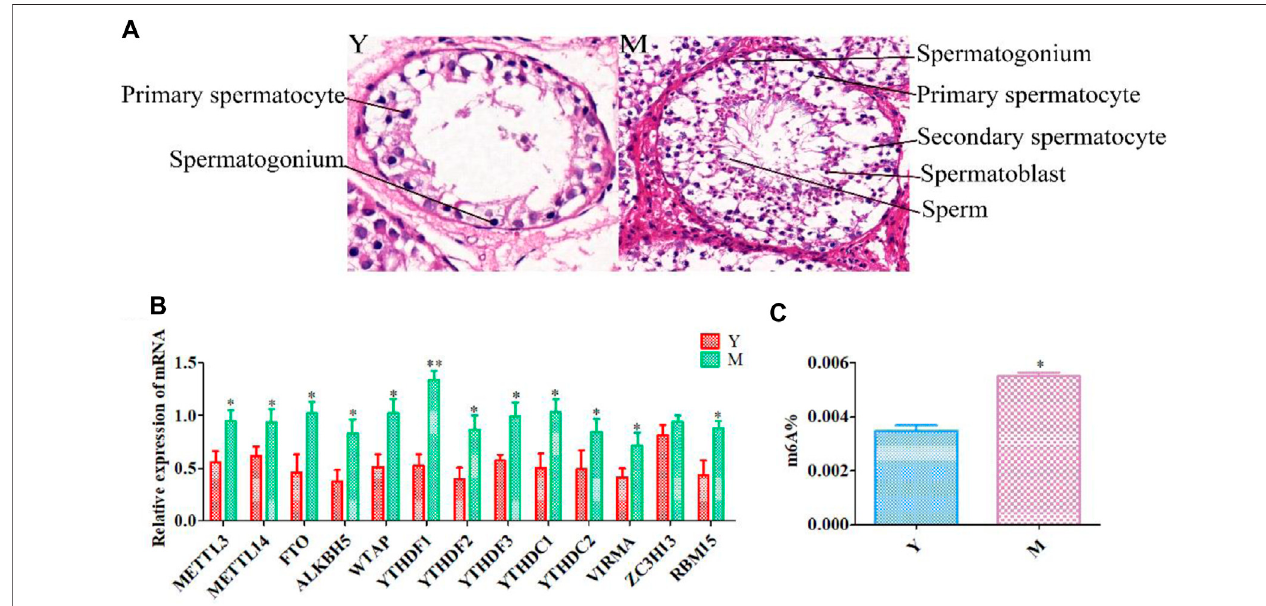
FIGURE1| HistologicalandqRT-PCRanalysis. (A) HEstainingofyaktestesbefore (Y) andafter (M) sexualmaturation. (B) Quantitativeexpressionofmethylation- related genes. (C) Overall RNA methylation levels in testicular tissue. ** p < 0.01, * p < 0.05.